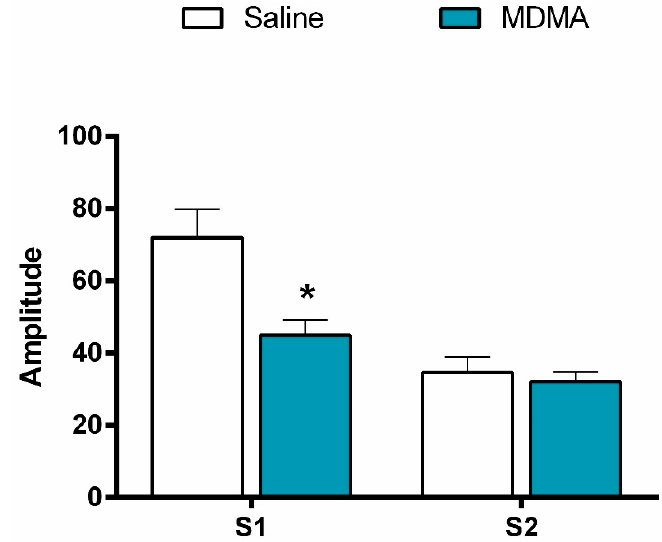
Figure 2. ( ± )-3,4-methylene-dioxymethamphetamine (MDMA) disrupted auditory sensory gating via a reduction in the S1 amplitude. Mean S1 and S2 amplitudes for all saline / saline and saline / MDMA conditions are displayed with error bars indicating standard error of the mean (SEM). * denotes significance at p < 0.05. N = 43.